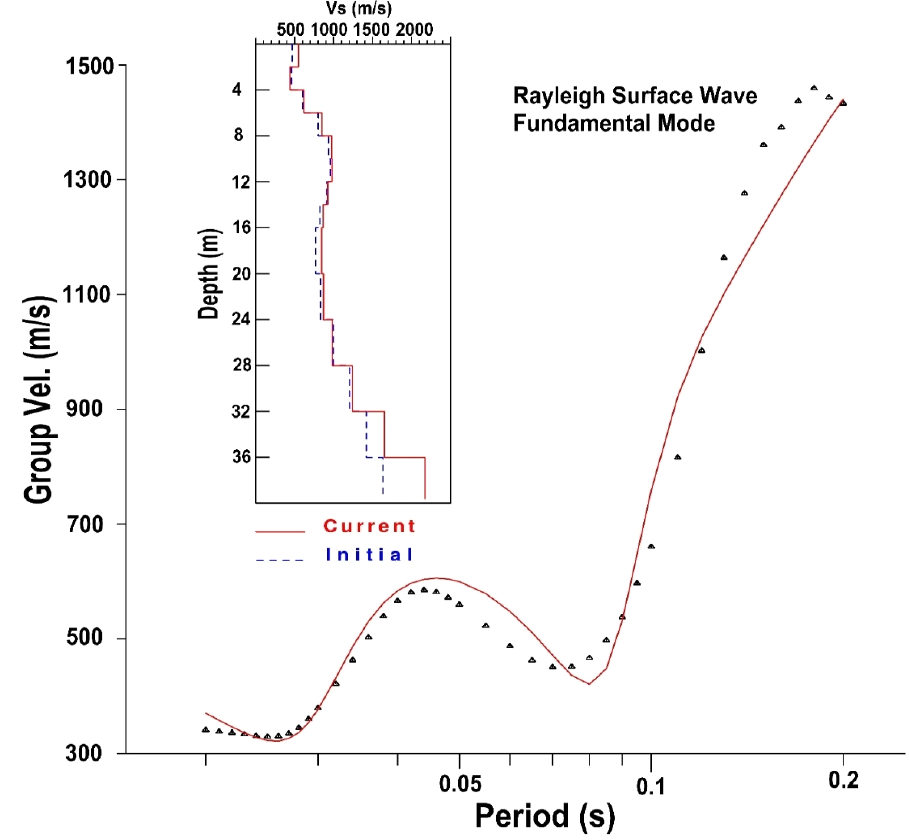
Figure 9. 1-D inversion result for the group velocity curve in Figure 8 is shown. 𝑽𝒔 stands for the shear-wave velocity (m/s). The horizontal axis shows the period